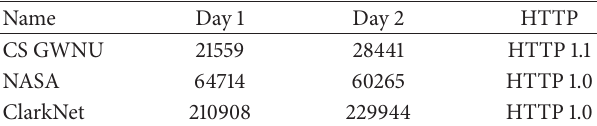
Table 2: Web access